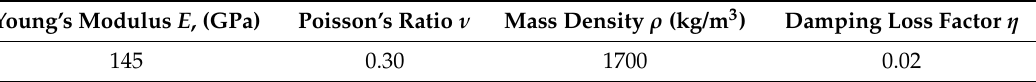
Figure 7. FE Model of a segmental PZT interface. Table 2. Material properties of FRP sheet.